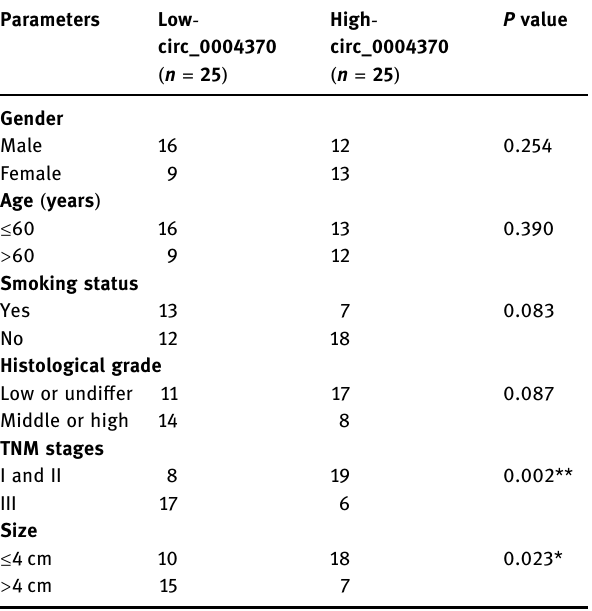
Table 1: The correlation between circ_0004370 expression